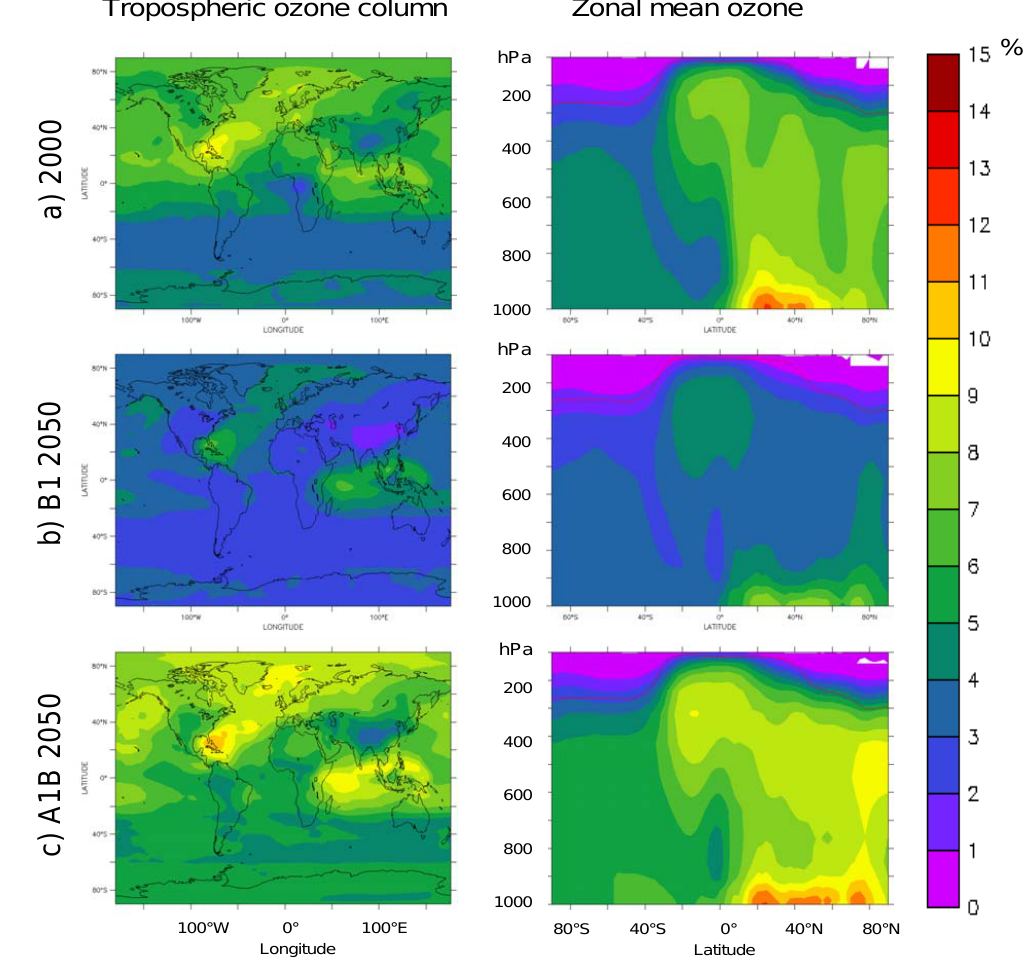
Fig. 5. Up-scaled perturbations (in %) in the ozone tropospheric column (left) and in zonal mean ozone mixing ratio (right) due to all transport modes, obtained for July for 2000 (A experiment) and 2050 (B1 and A1B scenario, i.e., B and C experiments)